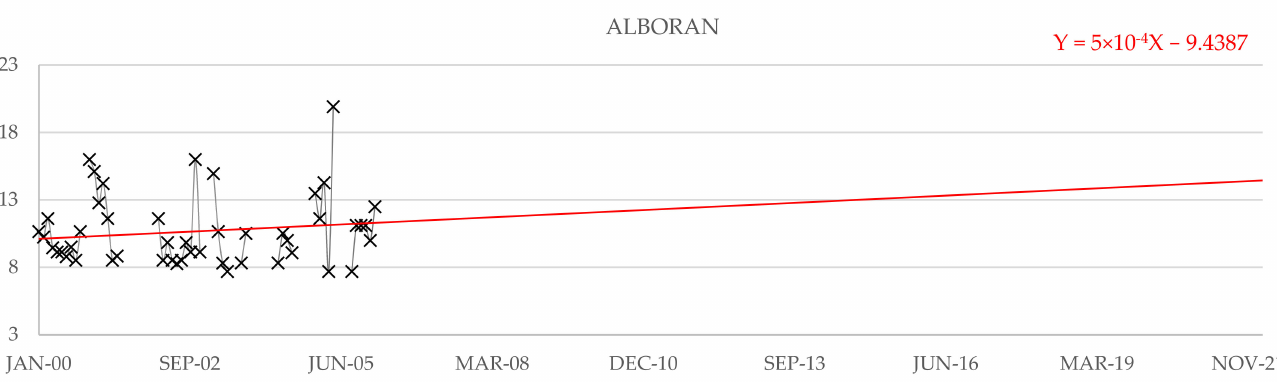
Figure 12. Evolution of Tp maxima in Alboran.